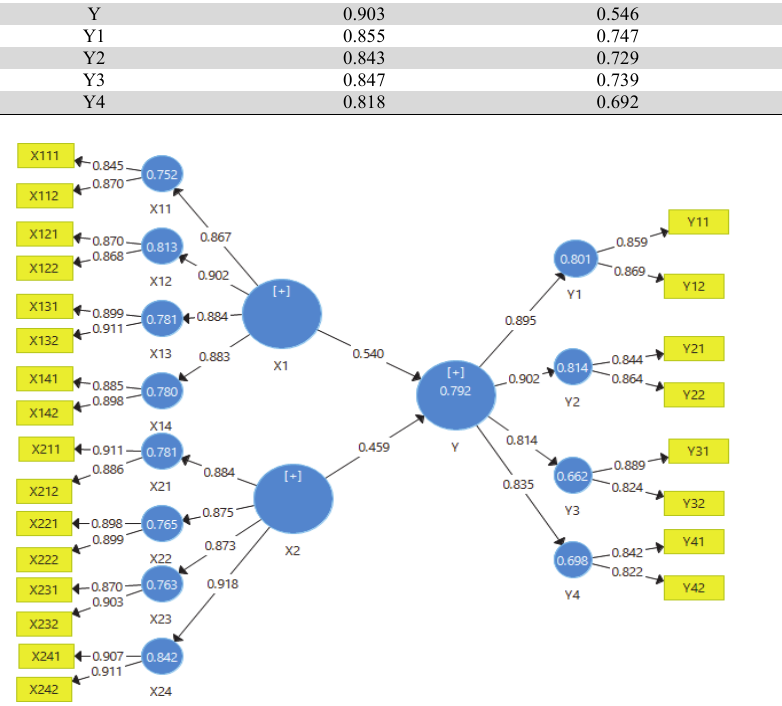
Fig. 2. The results of path